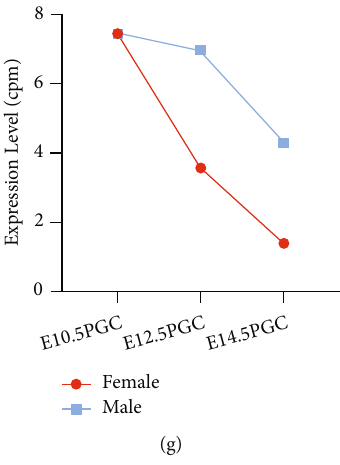
Figure 3: RNA-Seq analysis reveals enhanced germ cell speci fi c gene expression in Rcor2 -/- mESCs. (a) Volcano plot of gene expression changes in Rcor2 -/- mESCs compared to WT mESCs. The blue, red, and gray dots indicate genes downregulated, upregulated, and unchanged, respectively ( threshold = 2 folds change, Log2FC = 1 ). (b) GO term analysis of biological processes enriched from the upregulated genes in Rcor2 -/- mESCs (no biological processes are enriched in downregulated genes). (c) The relationship of the upregulated genes in Rcor2 -/- mESCs (black) and the enriched biological processes (red). (d) Heat map of PGC-related upregulated genes in Rcor2 -/- mESCs and in WT and Rcor2 -/- mESCs, WT mESCs, and E10.5 PGC [13]. (e) The relative expression of Rcor2 in WT mESCs at day 0, day 2, day 6, and day 9 of spontaneous random di ff erentiation. (f) The count per million (cpm) of Rcor2 from exiting RNA- Seq datasets during PGC-like cell (PGCLC) di ff erentiation [14]. (g) The expression of Rcor2 in count per million (cpm) from published RNA-Seq datasets during E10.5 PGC stage to E14.5 PGC stage [13]. (e) Data are expressed as mean ± SEM , n = 3 , ∗ p < 0 : 05 , ∗∗ p < 0 : 01 , ∗∗∗ p < 0 : 001